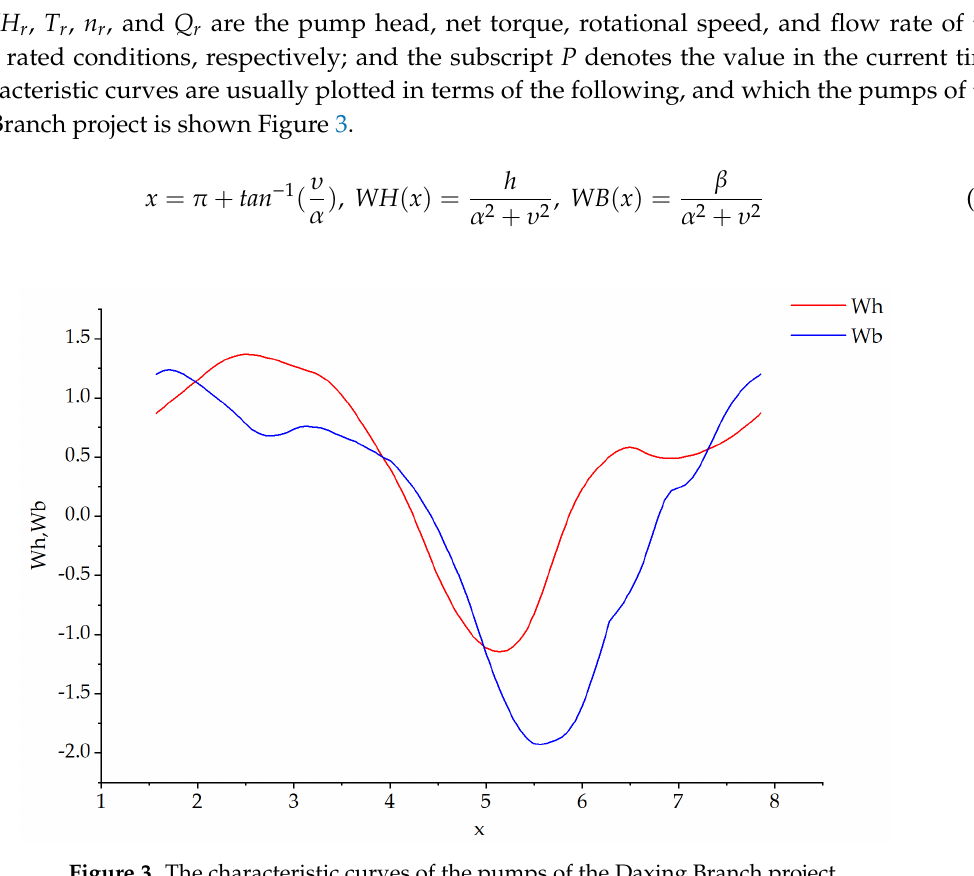
Figure 3. The characteristic curves of the pumps of the Daxing Branch project.